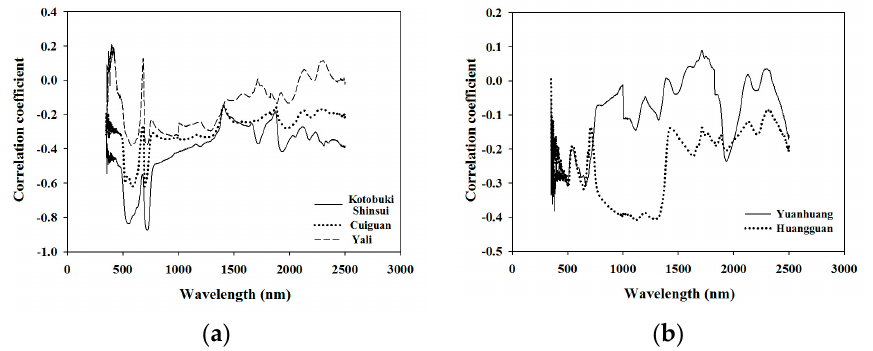
Figure 2. Correlation coefficient between different varieties of leaf nitrogen concentration and the original spectra. The trend of correlation coefficients of Kotobuki shinsui, Cuiguan, and Yali were found to be similar to each other, which showed a higher correlation in the 550 nm (green peak) and